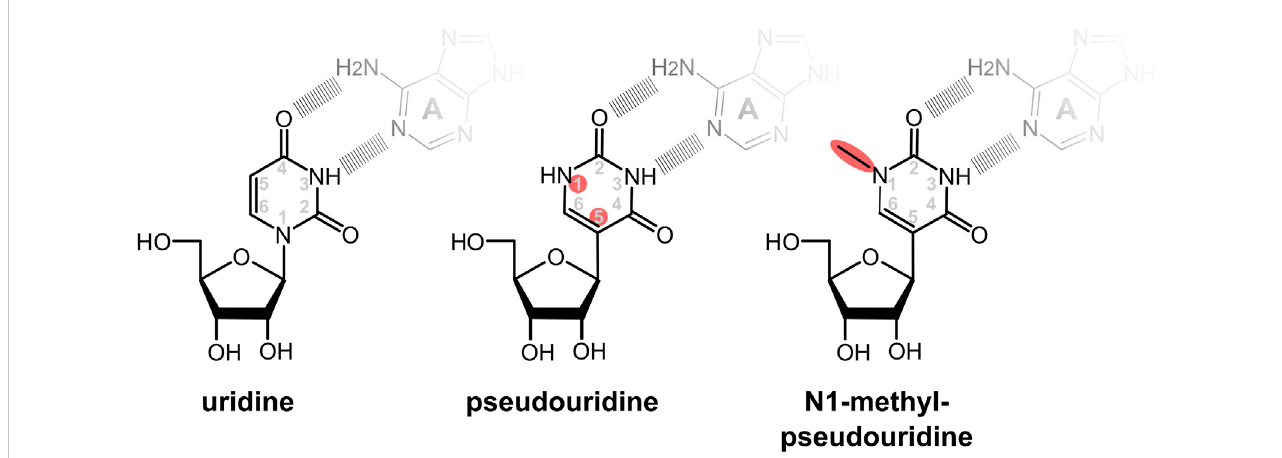
FIGURE 4 Modi fi ed nucleotides used to ablate stimulation of immune responses and PKR activity by IVTmRNAs. In pseudouridine the uracil base is rotated so that theglycosidicbondbetweenthesugarandbaseistransferredfromtheN1totheC5atomofthebase.InthecommonlyusedbaseN1-methyl-pseudouridine, theN1atomisattachedtoanadditionalmethylgroup.Despitetherotationofthebase,thepotentialtoformbasepairingpatterns via theWatson-Crickfaceof the uridine is maintained in the modi fi ed bases. Sites of changes relative to native uridine are highlighted in